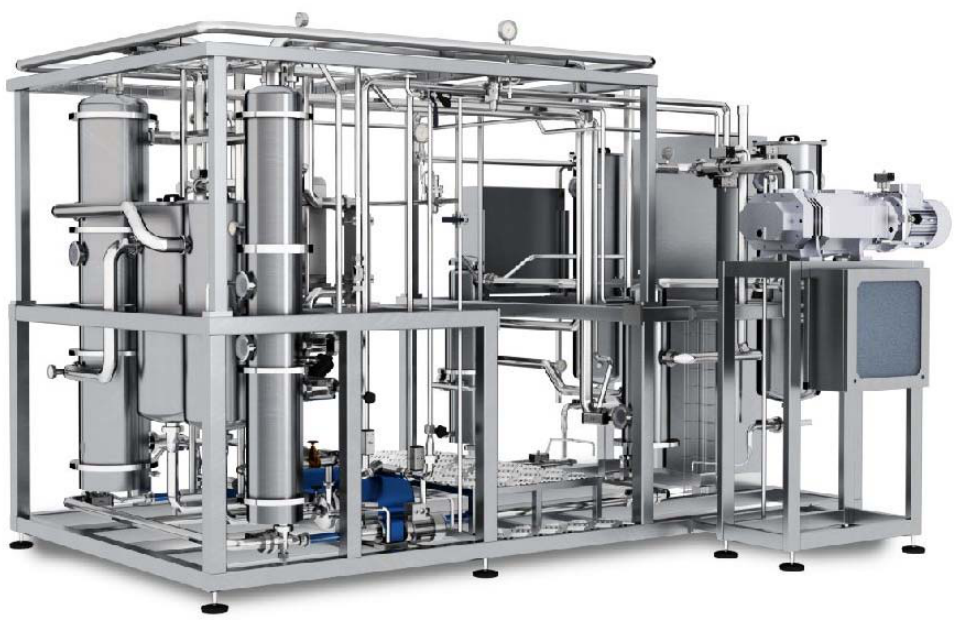
Figure 1. Multiple-Effect Fractional Condensation Under Vacuum (MEFCUV) (Tropical Food Machinery, Busseto Italy).